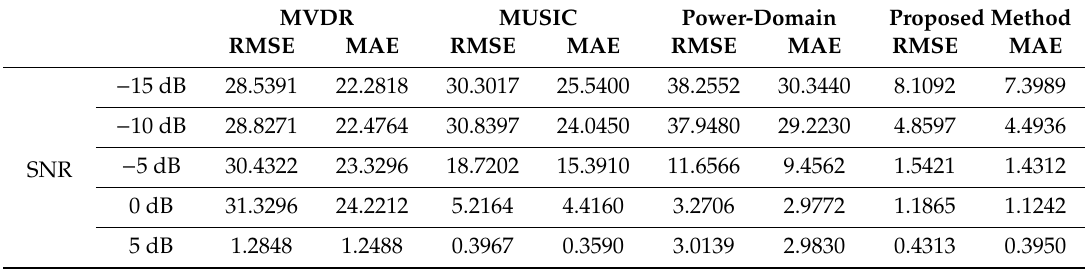
Table 2. DOA evaluation for the di ff erent estimators (MUSIC, MVDR, Power-Domain, and the proposed estimator) in Example